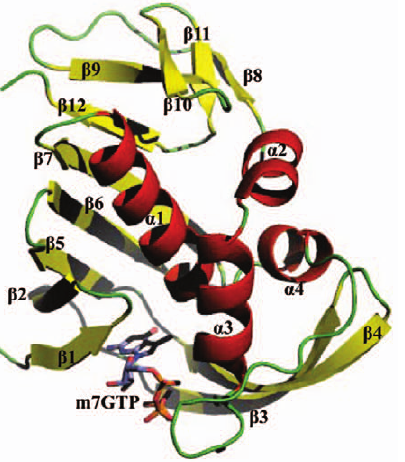
Figure 1. Illustratively showing the binding mode of the PB2 cap binding domain in the presence of the cap analog m7GTP. The protein structure was shown in a ribbon diagram, while m7GTP is in ball-and-stick representations. The secondary structure elements of the PB2 cap binding domain are labeled with a -helices in red and b -strands in yellow. The cap analog m7GTP is colored according to its atomic types.